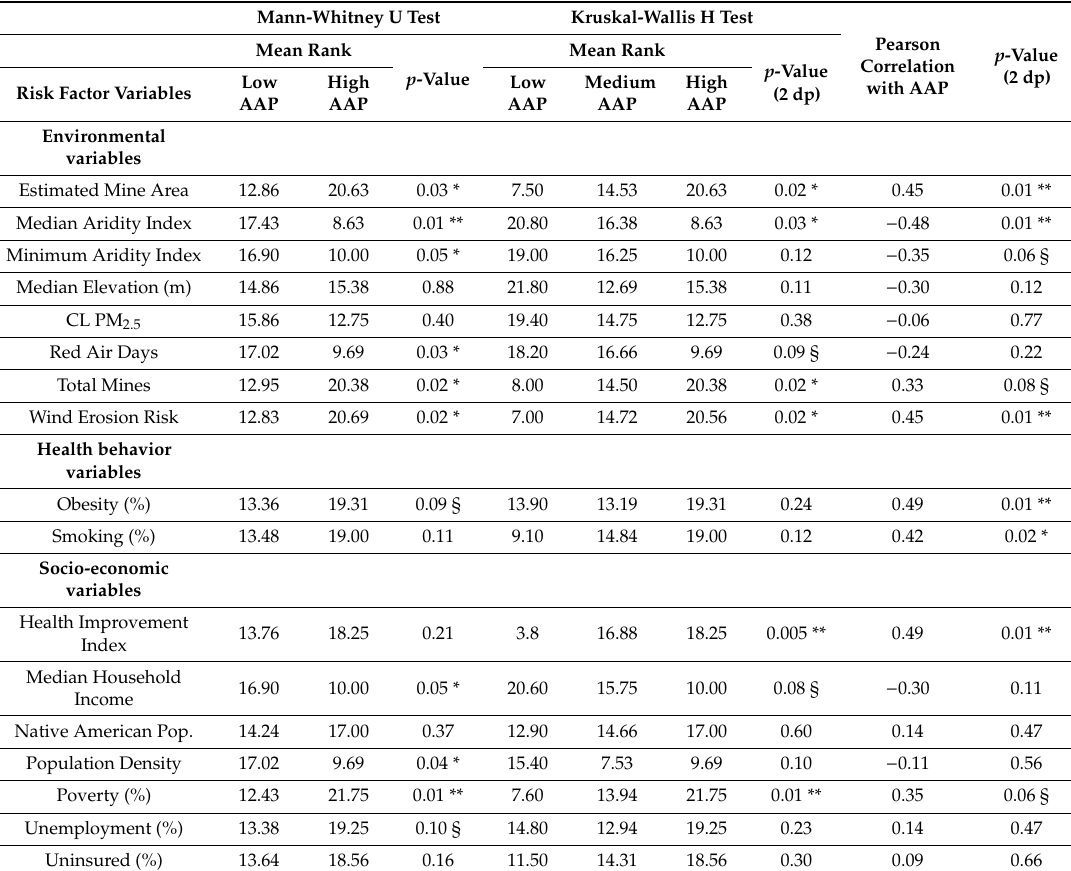
Table 2. Mean ranks of risk factor variables for low and high AAP groups (Mann-Whitney U test) and low, medium and high AAP groups (Kruskal-Wallis H test) and Pearson correlation of risk factors with